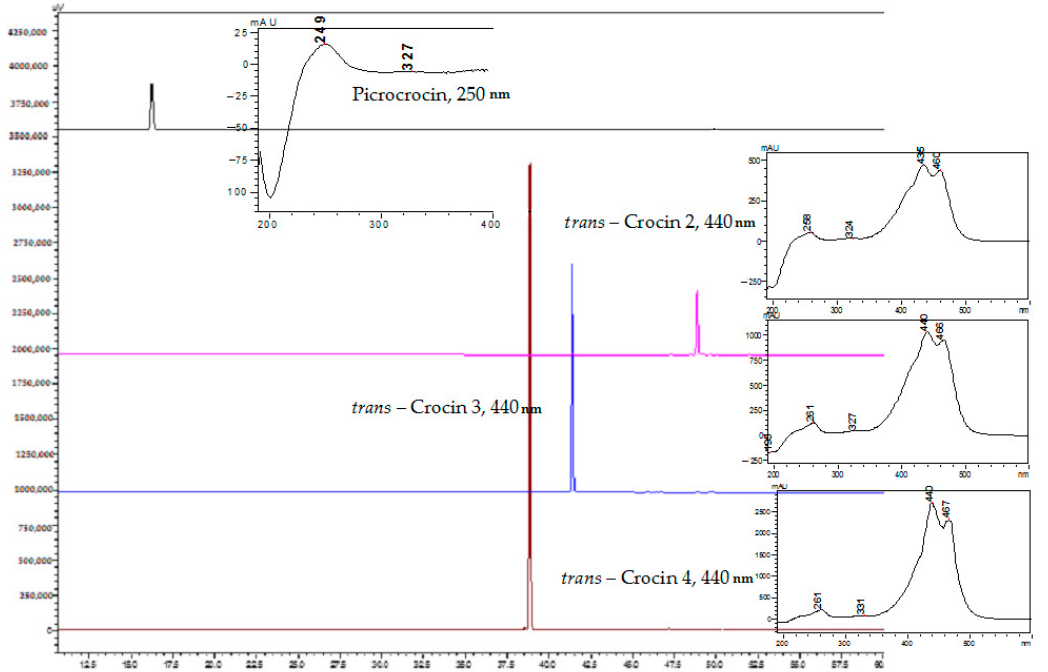
Figure 5. HPLC-DAD chromatograms of pure saffron compounds.